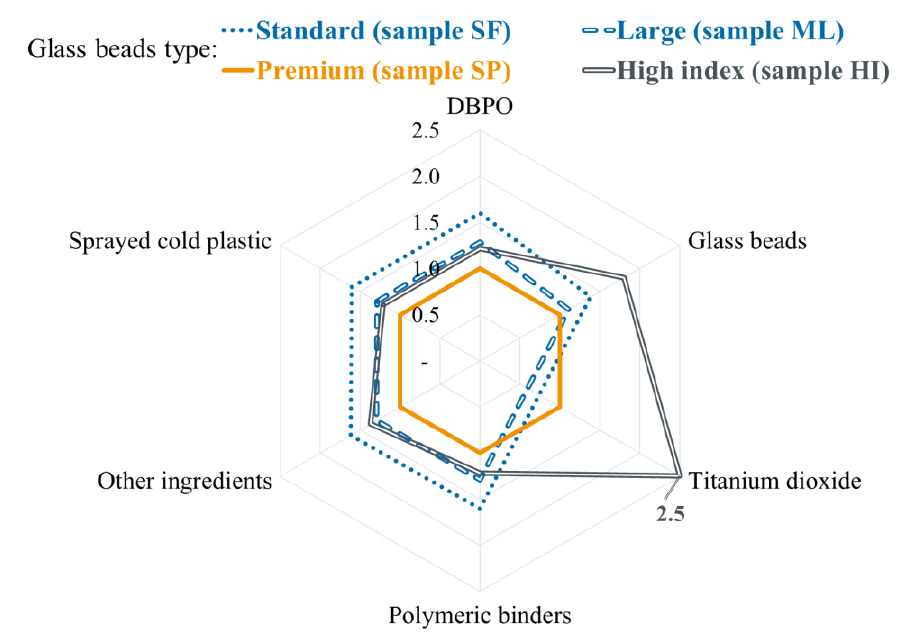
Figure 10. Relative long-term material consumption to maintain R L > 150 mcd/m 2 /lx for 100,000 drum rotations (abrasive testing). The premium GB (sample SP ) was assumed as 1.0 (arbitrary unitless scale).